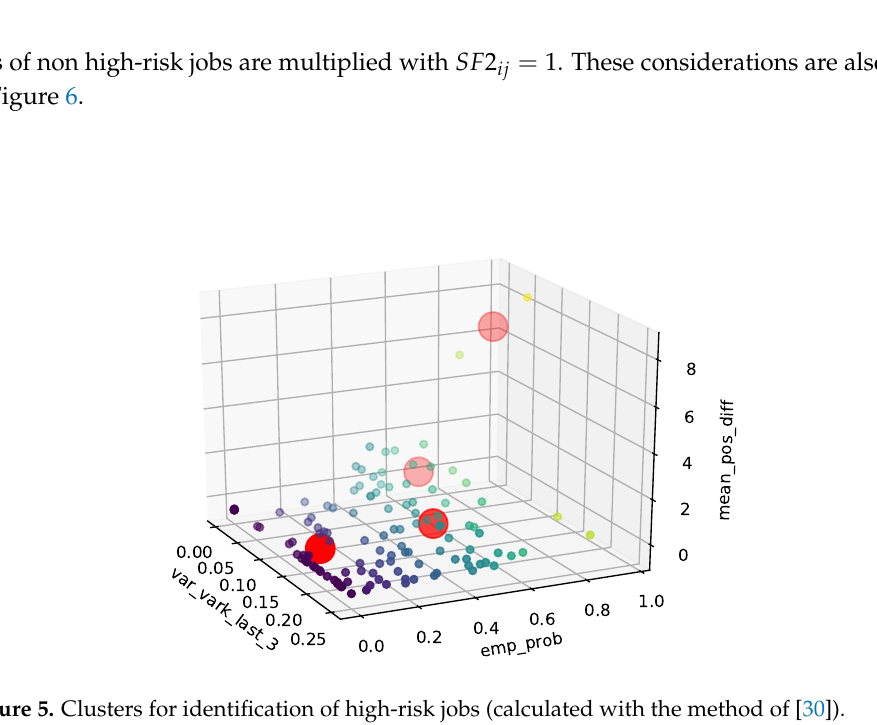
Figure 5. Clusters for identification of high-risk jobs (calculated with the method of